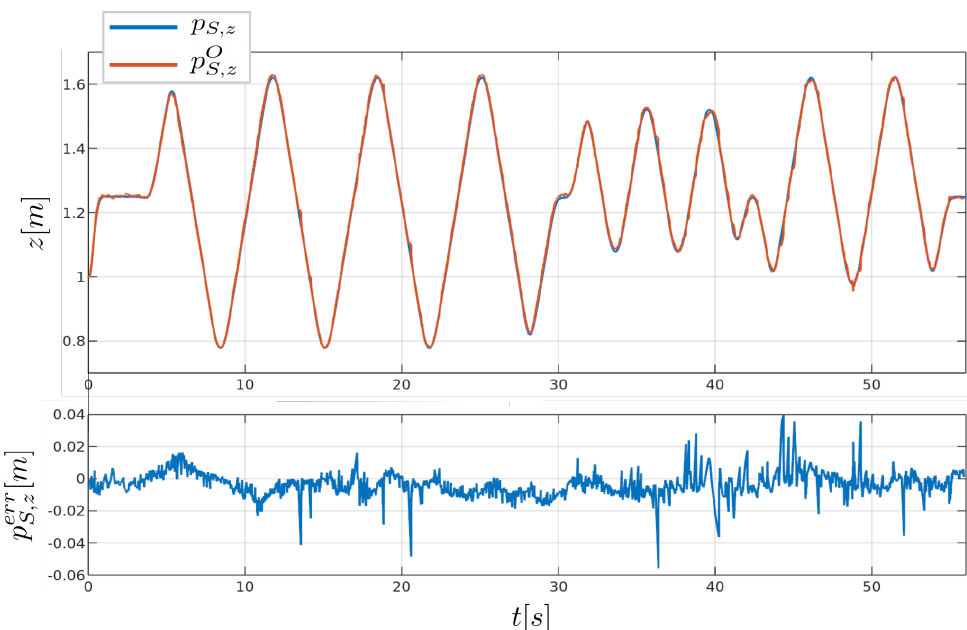
Figure 15. Comparison between the z component of the spray frame position determined by the encoder measurements, and that determined externally via the Optitrack camera system, denoted p S , z and p O , respectively. The bottom plot shows the corresponding error p err S , z